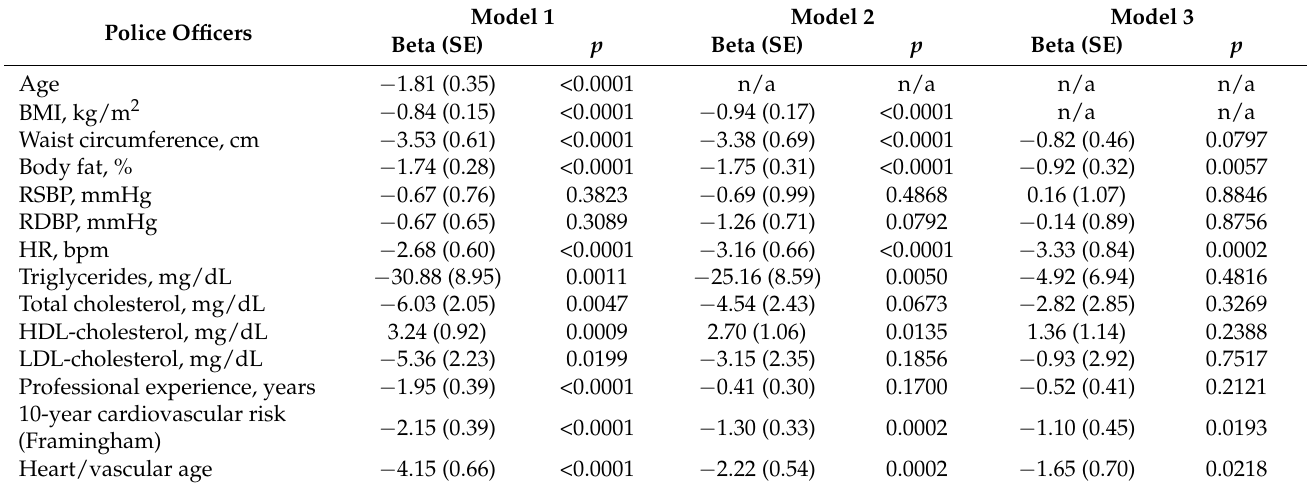
Table 4. Linear regression models of cardiovascular risk factors and METs as continuous variable for police officers.